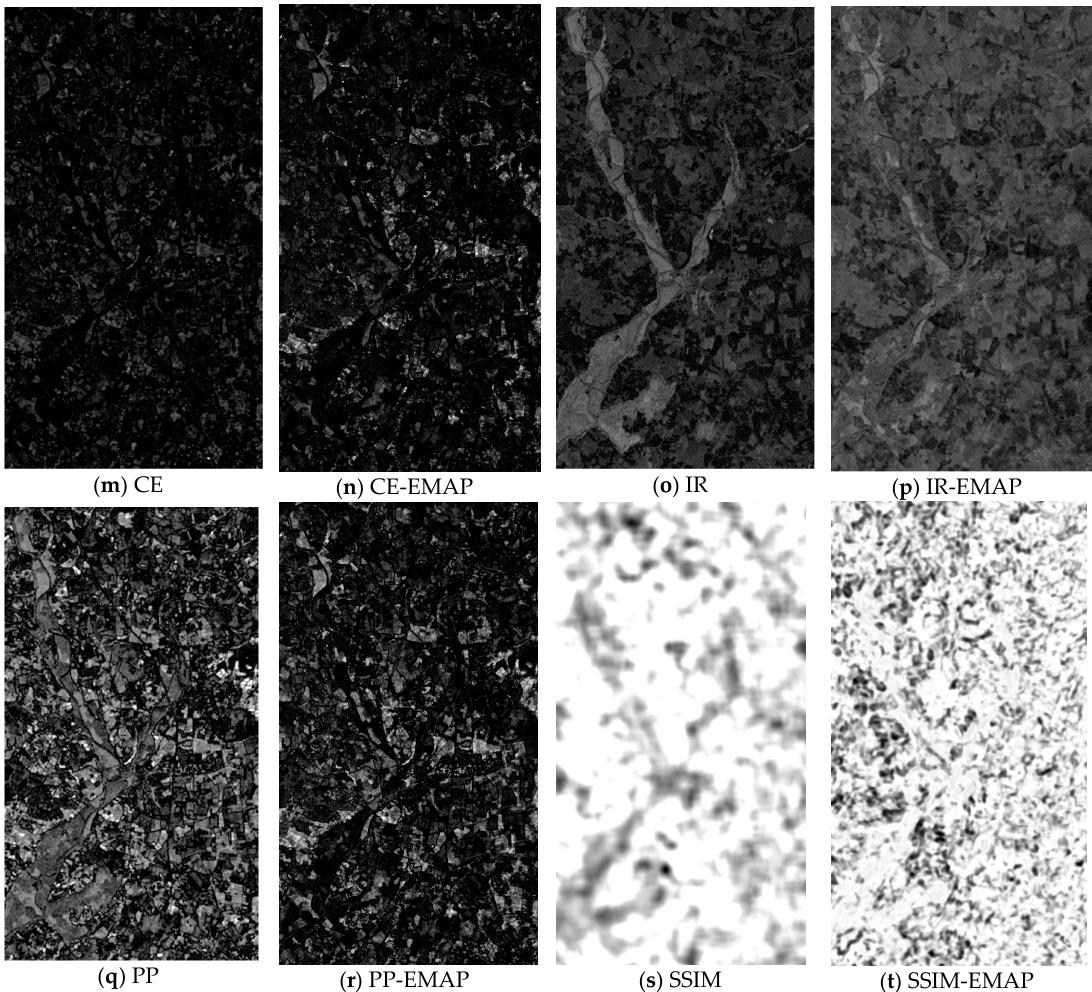
Figure 5. Change detection images using different methods with and without EMAP (Image Pair-1). Remote Sens. 2019 , 11 , x FOR PEER REVIEW